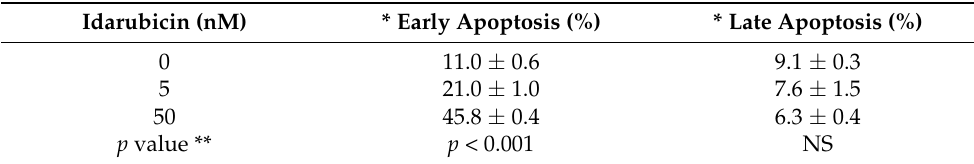
Table 1. Idarubicin Induces ATRA-NB4 Cells to Enter the Process of Apoptosis.